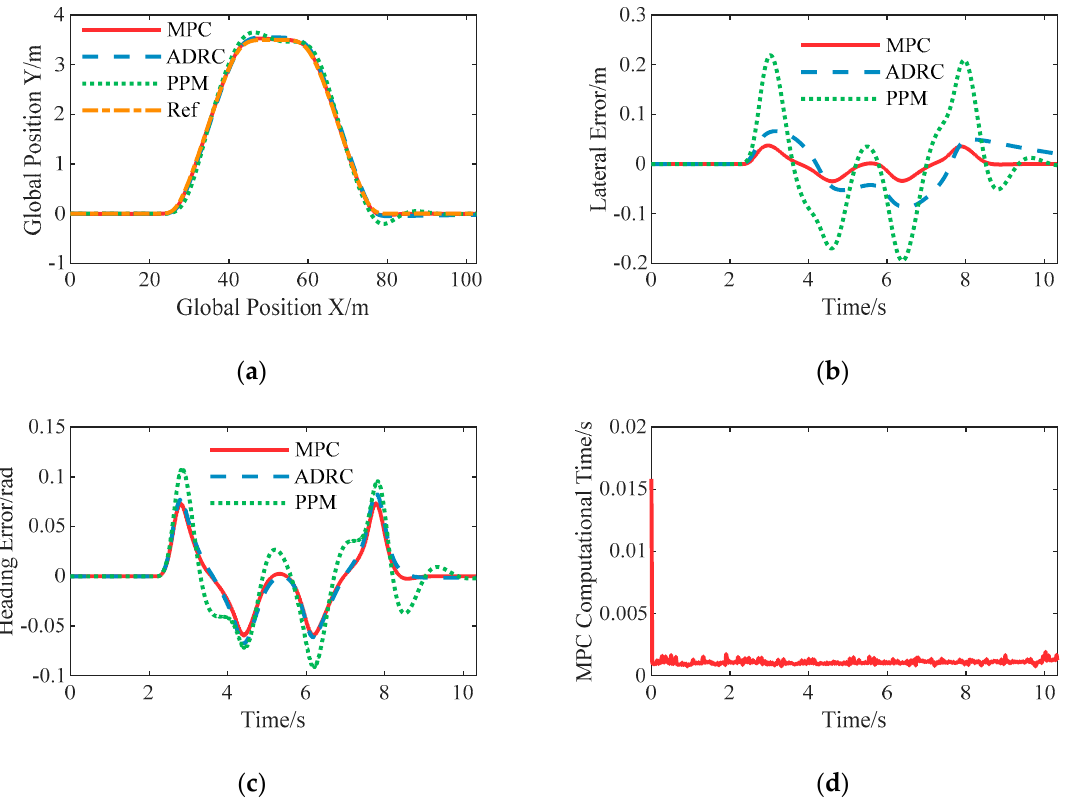
Figure 10. Simulation results of double lane change with constant speed 10 m / s: ( a ) The spatial path of the vehicle following the given path; ( b ) The resulting lateral error; ( c ) The resulting heading angle error; ( d ) The computational time of the proposed LPV-MPC controller. Table 2. Quantitative statistics of lateral error and heading error in the double lane change scenario.